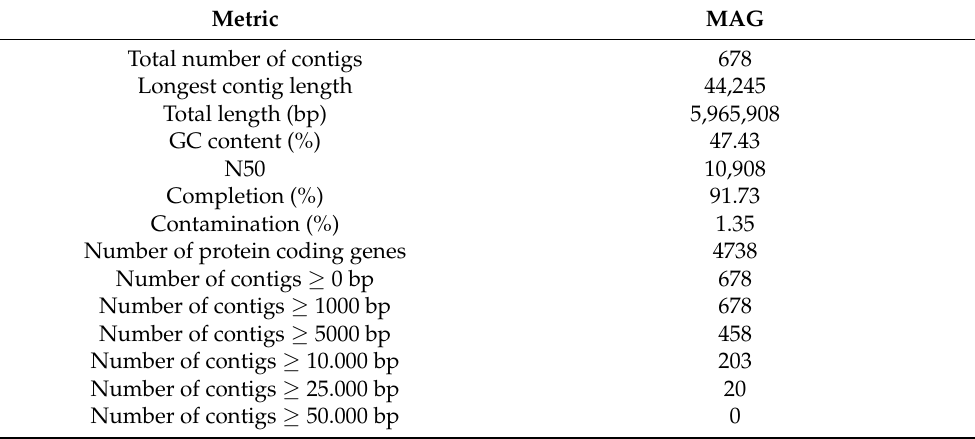
Table 3. Quality metrics of the P. pseudopriestleyi metagenome-assembled genome (MAG). All statistics are from QUAST v4.4, except for completion and contamination statistics which were generated from CheckM v1.0.7 and the number of protein coding genes from Prokka